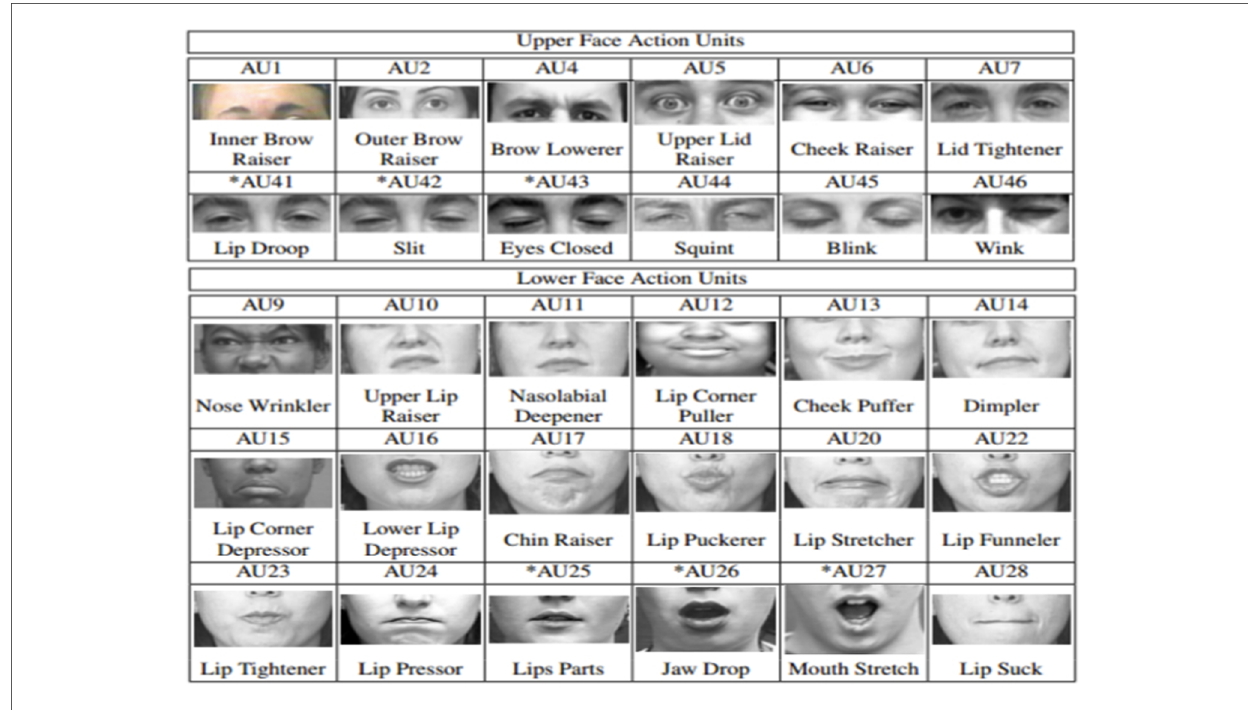
FIGURE 2 The criteria of facial action units (73,